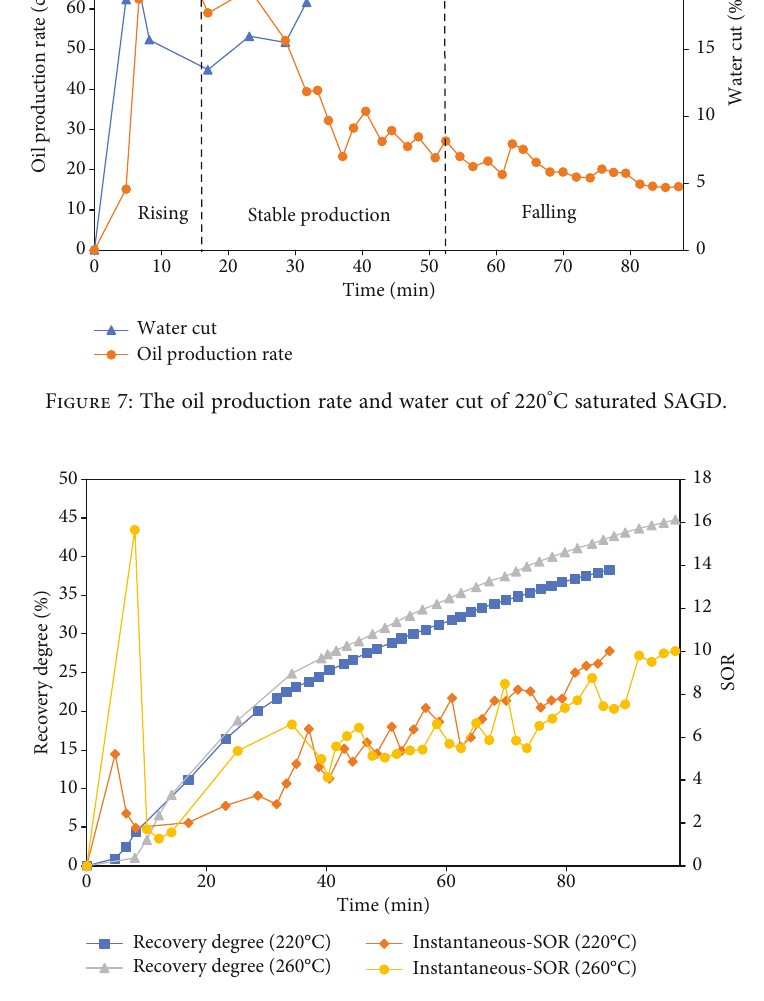
Figure 8: Comparison of superheated SAGD (260 ° C) and saturated SAGD (220 °